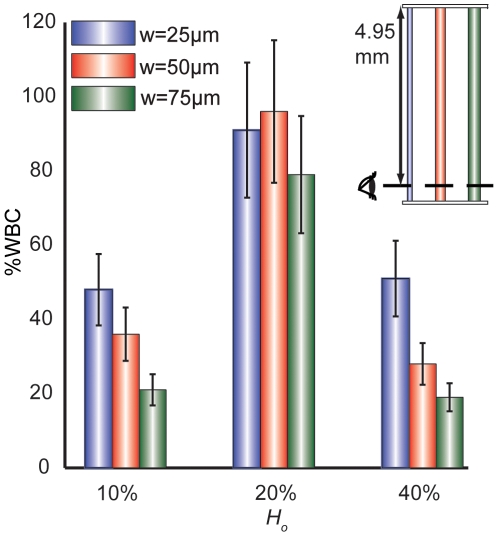
Post-capillary expansions improve WBC margination.In plasma or with dextran 500, when Ho = 20% and y = 1.2 mm, WBC margination is improved in a 25–50 µm sudden expansion compared to a 25 µm or 50 µm straight channel. However, in RPMI 1640 where blood aggregation is not significant, straight channels exhibit better margination.